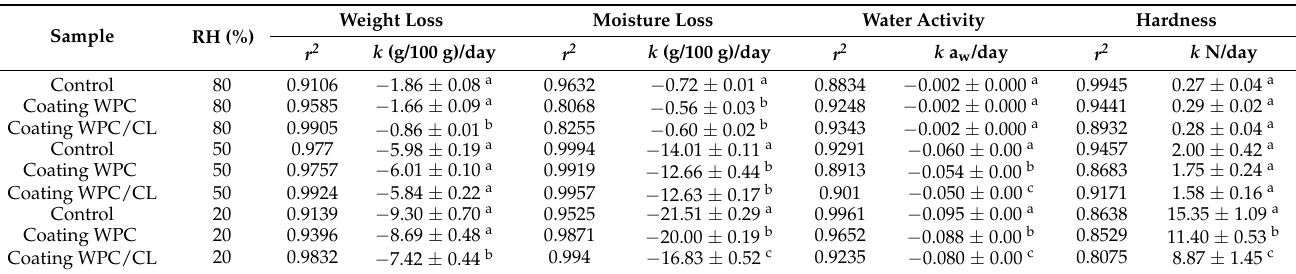
Table 3. Kinetics parameters from the quality properties of the stored muffins at 20 ◦ C and different relative humidity (20, 50, and 80%) for 5